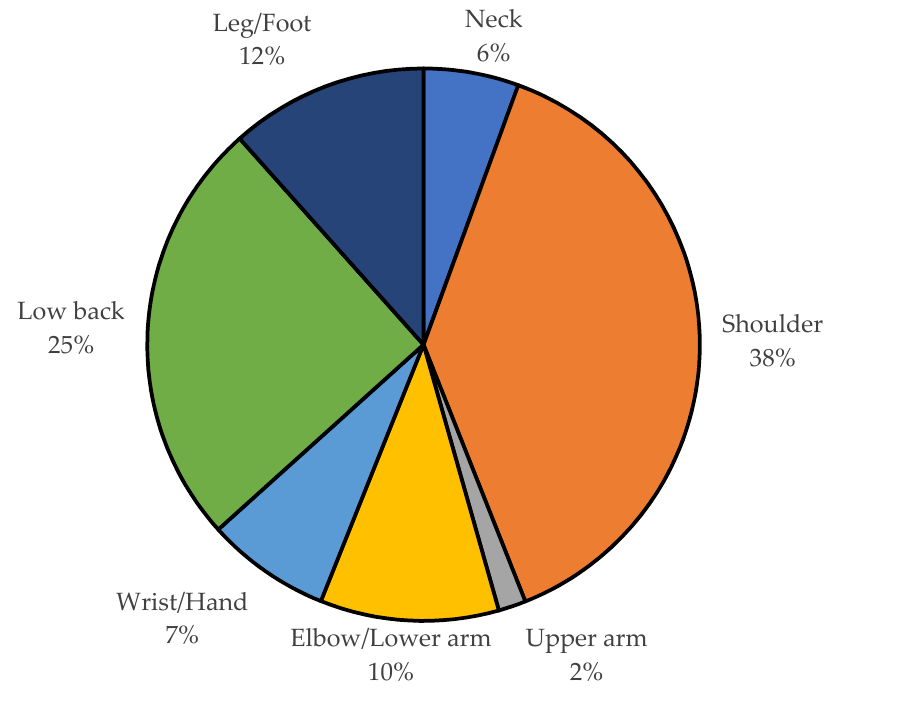
Figure 8. Distribution of WMSDs by body parts. Table 1. WMSDs by body parts and names.